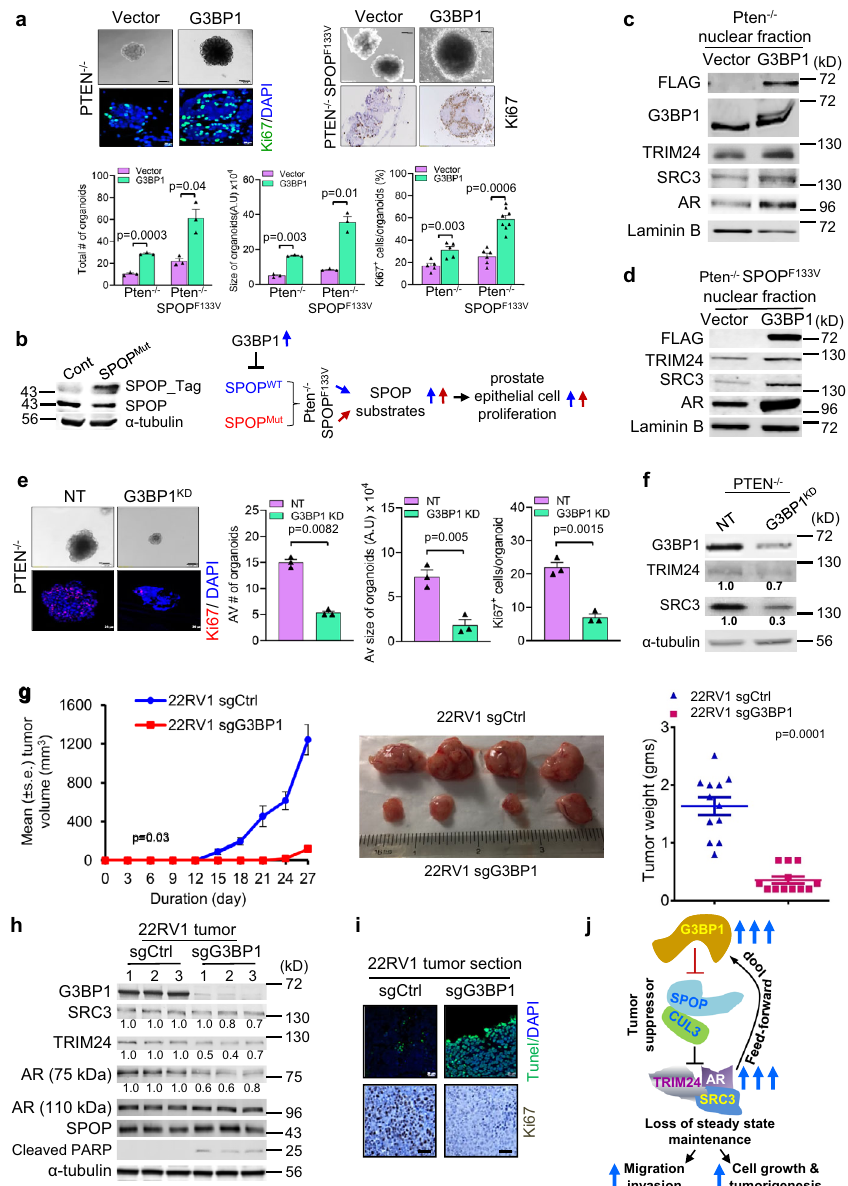
Fig. 7 G3BP1 suppresses SPOP function to facilitate organoid formation and tumorigenesis. a DOX-inducible empty vector (Ctrl) and G3BP1 (overexpressed) stable lines were generated from Pten − / − (upper left) and Pten − / − SPOP F133V (upper right) mPECs. Photomicrographs of representative mouse prostate organoids (scale bar, 200 μ m) and Ki67 (scale bars; left 20 μ m, right, 200 μ m) staining from the indicated mouse genotype following quanti fi cation of organoids number (lower left n = 3) and size (lower middle, n = 3) and Ki67 positive cells (lower right) n = 3 biologically independent experiments. Error bars, ±S.E.M. Paired t -test. ( b left) Immunoblot analysis showing WT-SPOP and FLAG - SPOP F133V expression. α - tubulin served as